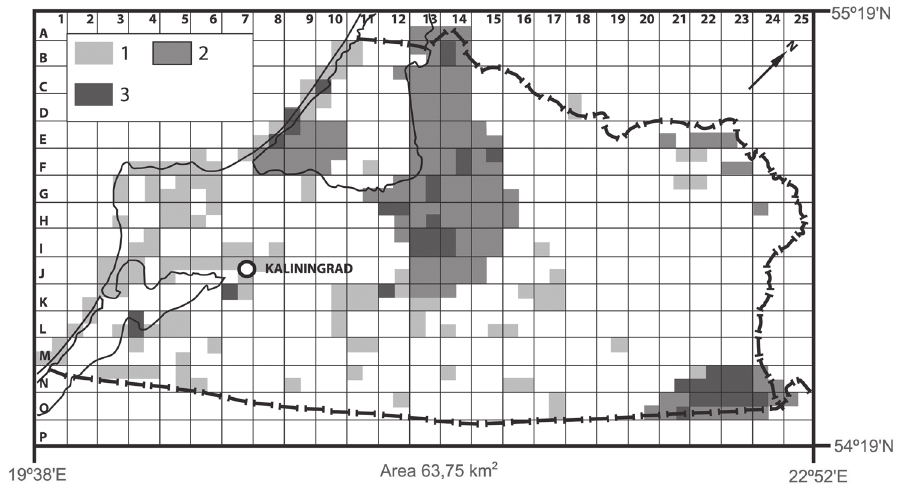
Figure 10. The protected plant and animal species spread in the territory of Kaliningrad region. 1 plants 2 animals 3 plants and animals